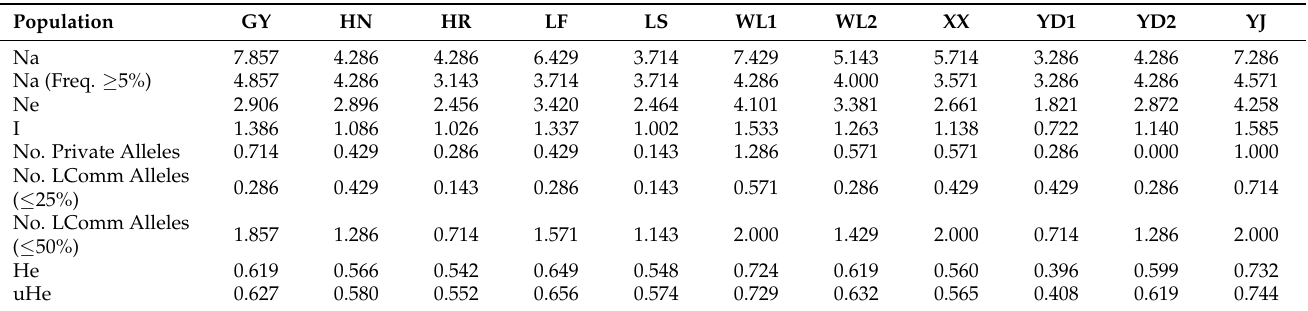
Table 4. Allelic diversity within 11 local populations of F. commune causing strawberry root rot in southcentral